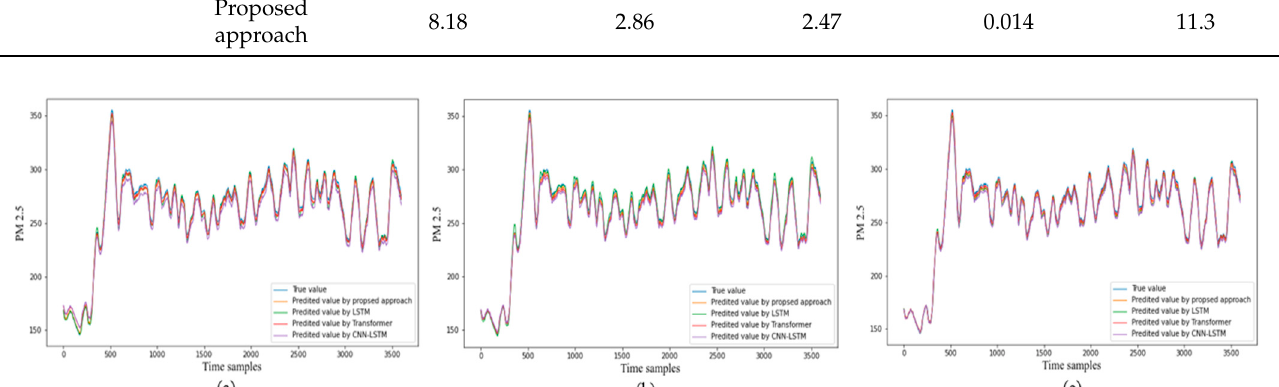
Figure 10. Fitting trends of model for 1 h ahead prediction for ( a ) 20 epochs, ( b ) 30 epochs, ( c ) 40 epochs.